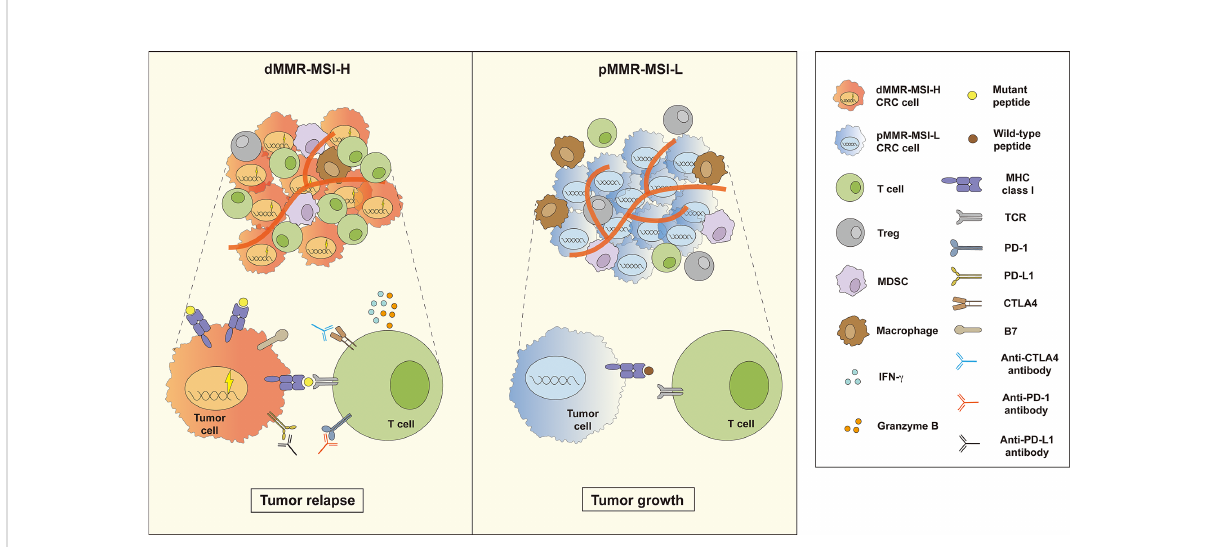
FIGURE 1 Two outcomes of immunotherapy in dMMR – MSI-H and pMMR – MSI-L CRC. Compared with pMMR – MSI-L, patients with dMMR – MSI-H experience better tumor reduction after treatment with immune checkpoint inhibitors (ICIs). Many functional tumor in fi ltrating lymphocytes (TILs) release a large number of cytokines such as IFN- g and granzyme B in the dMMR – MSI-H tumor microenvironment (TME). However, the TME of pMMR – MSI-L CRC contains fewer functional TILs and more immunosuppressive cells, such as Tregs, MDSCs, and TAMs, which inhibit TIL